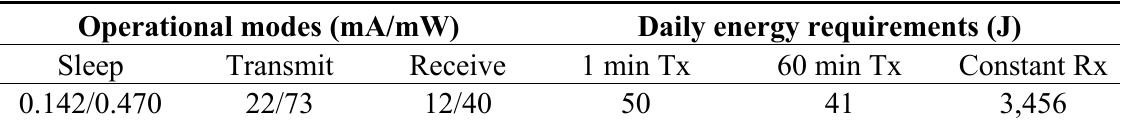
Table 2. Fleck 3B energy and power consumption at 3.3 volts. Energy requirements for different regimes given; sleeping except to sample and transmit once every 1 min, sleeping except to sample and transmit once every 60 min, and as a permanent